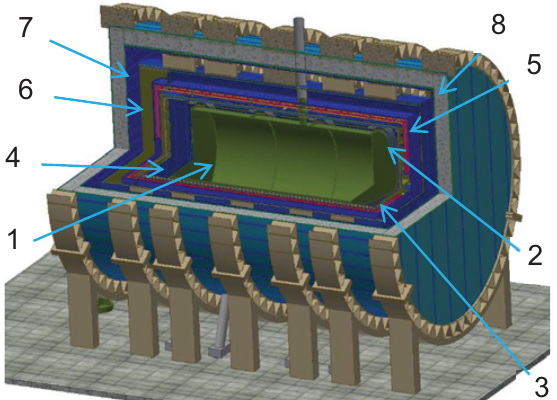
Figure 1. Schematic of the setup with a 90 ◦ cutout to show the inner structure of the trap. 1: UCN trap, 2: vacuum vessel, 3: magnetic screen, 4: inner tracker, 5: inner hodoscope layer, 6: middle tracker, 7: outer hodoscope layer, 8: outer